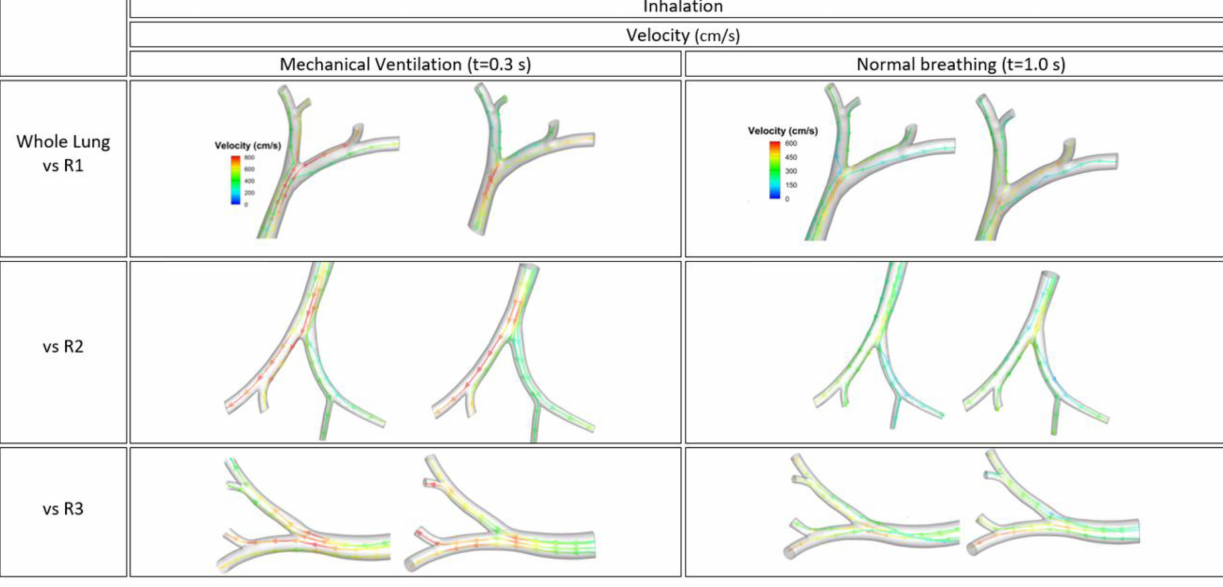
Figure 10. Comparison of airflow velocity for right bifurcations of whole lung and isolated local bifurcations (R1, R2, and R3). The plots are for the MV and NB during inhalation at t = 0.3 s, t = 1.0 s,